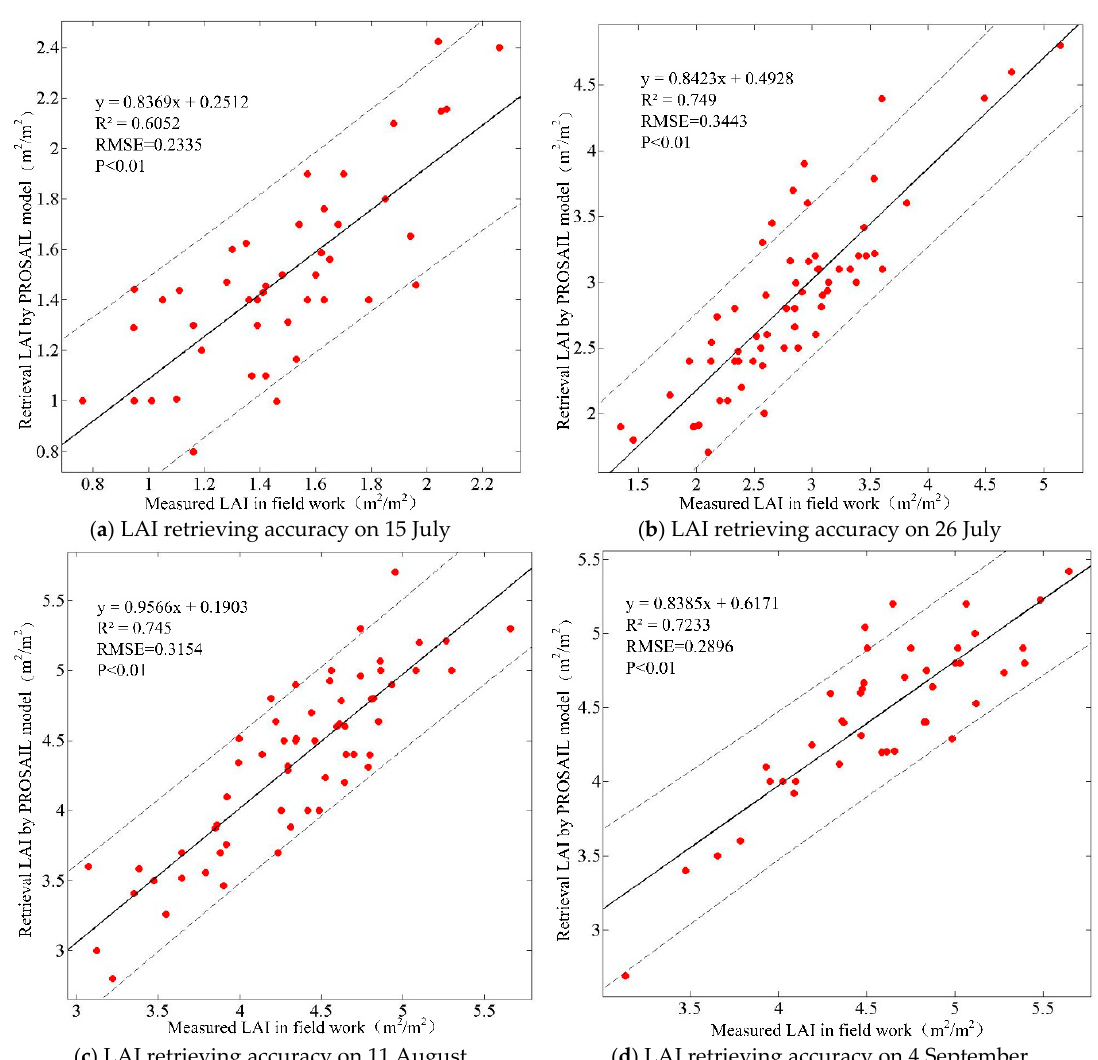
Figure 9. Comparison between the LAIs measured in situ and the retrieved LAIs using the PROSAIL model on ( a ) 15 July (stem elongation stage), ( b ) 26 July (the flare opening stage), ( c ) 11 August (the heading stage), and ( d ) 4 September (the milking stage). The broken lines represent the 95% confidence interval.